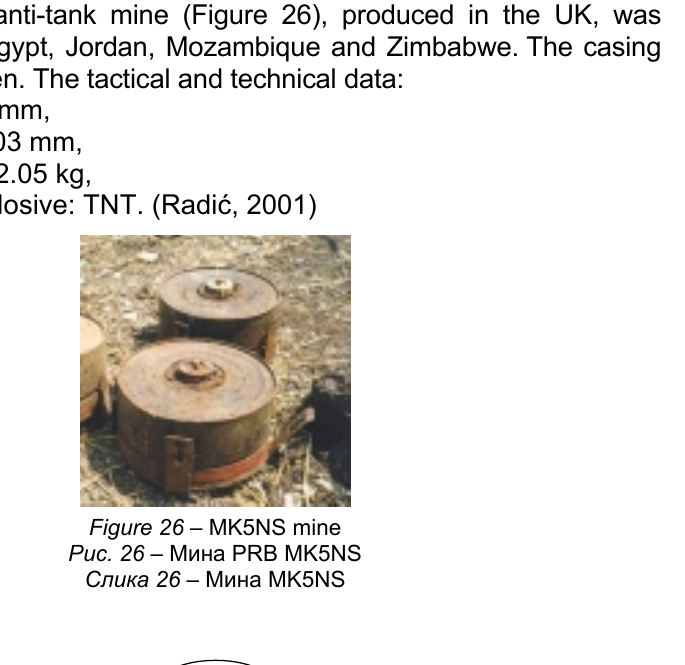
Figure 26 – MK5NS mine Рис . 26 – Мина PRB MK5NS Слика 26 – Мина